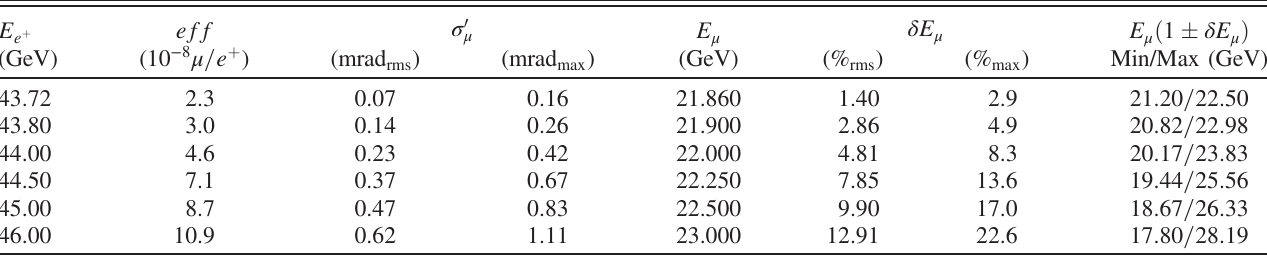
TABLE I. Muon production efficiency eff , divergence σ 0 μ and energy spread δ E μ as a function of the positron beam energy E e þ . The muon energy and divergence have a flat distribution. Efficiency has been estimated for 1% of a radiation length of Beryllium (3.5 mm of material). The muon beam divergence and energy spread are given by the collision kinematics.